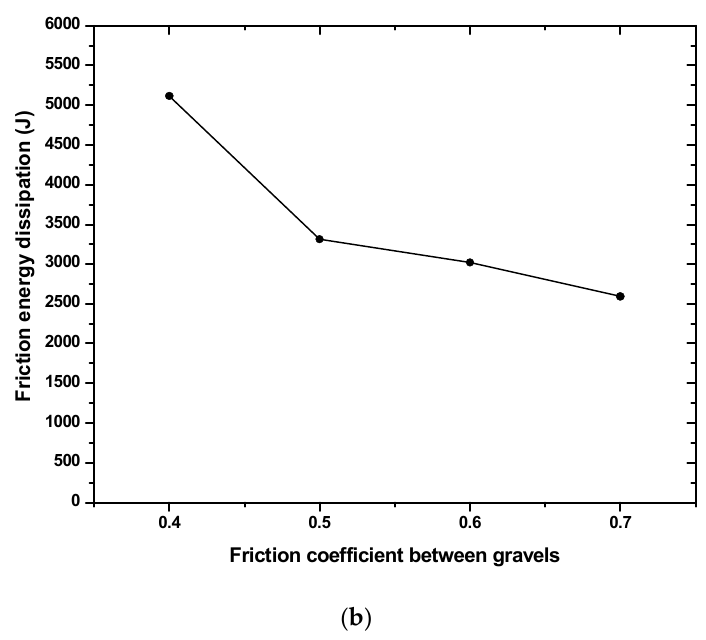
Figure 13. Comparison of friction energy dissipation with different friction coefficients between pieces of gravel: ( a ) variation; ( b ) change of maximum friction dissipation owing to the considered friction coefficient.